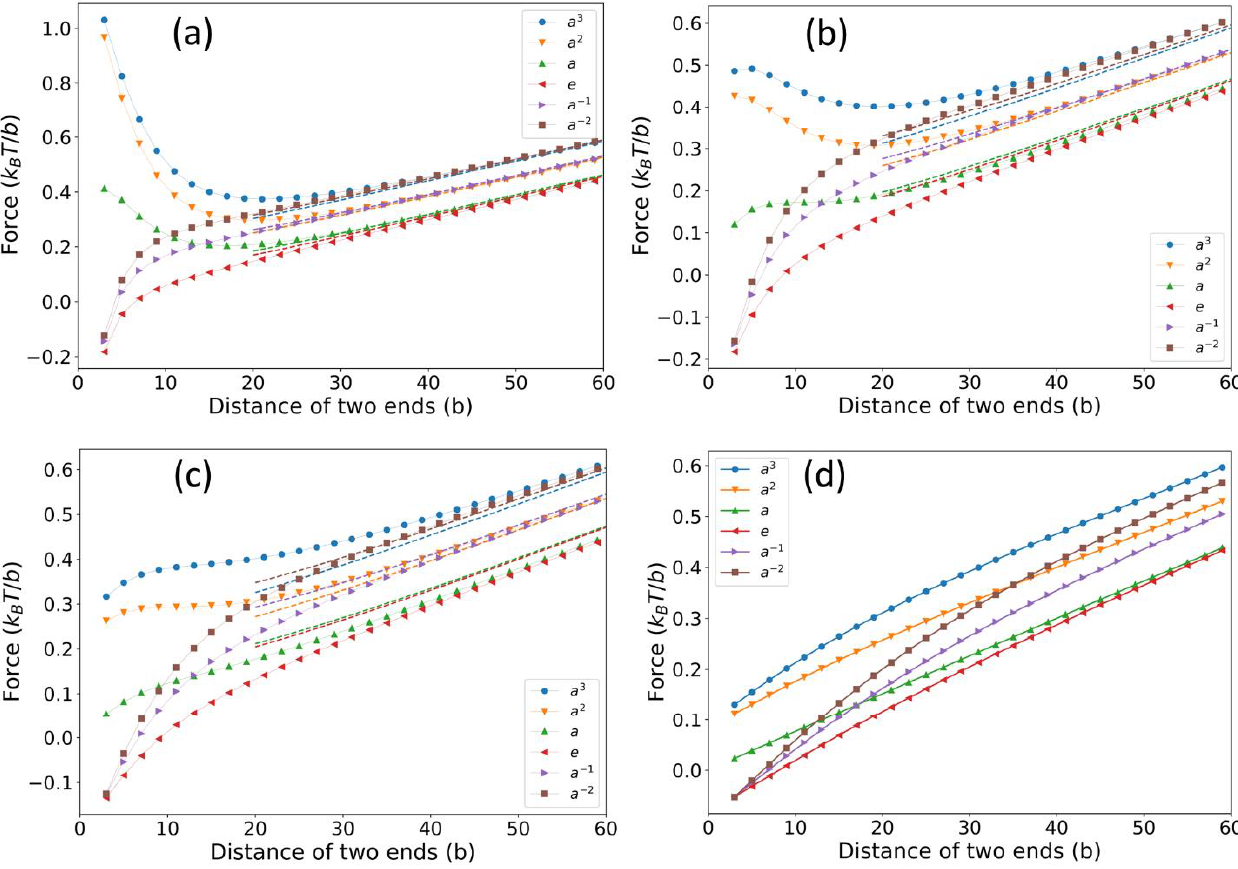
Figure 7. The influence of the overall radius of the ring on the entropic force of an ideal chain en- tangled with a static ring-shaped object with six different entangling modes. In this plot, the dis- tance, 𝐿 , between the two chain ends is 3𝑏 .